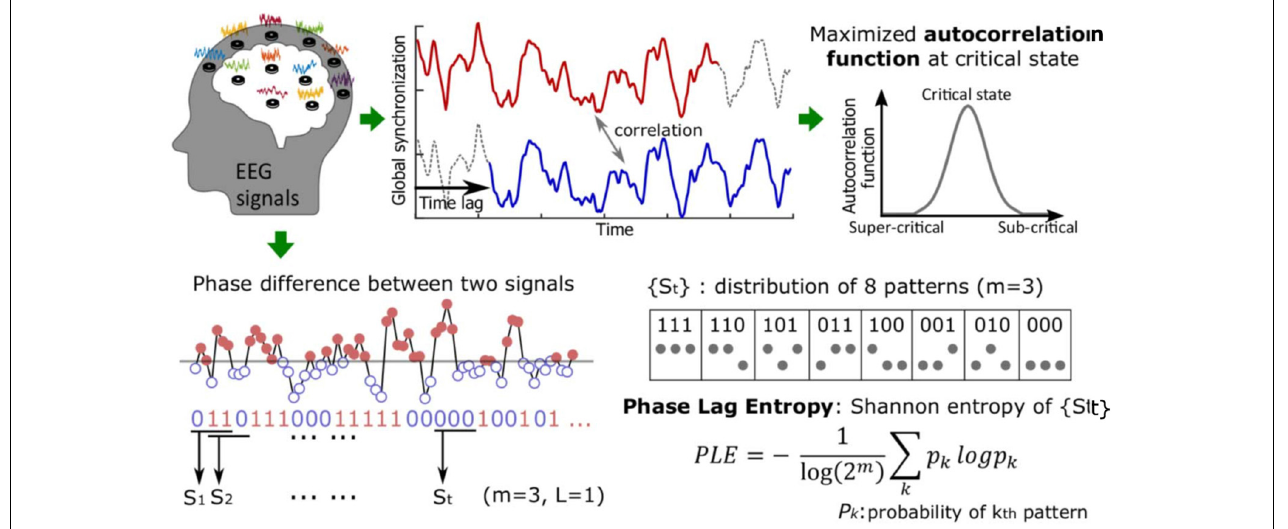
FIGURE 1 | Whole-scalp, 16-channel electroencephalographic (EEG) data were obtained from all participants. Following preprocessing, autocorrelation function and phase lag entropy (PLE) were analyzed from the EEG waveform data. The autocorrelation of global synchronization was calculated with various time lags. For PLE, the phase difference was first calculated and binarized to compute the distribution of the patterns. PLE was then defined with the Shannon entropy of the probability of the patterns (see text for